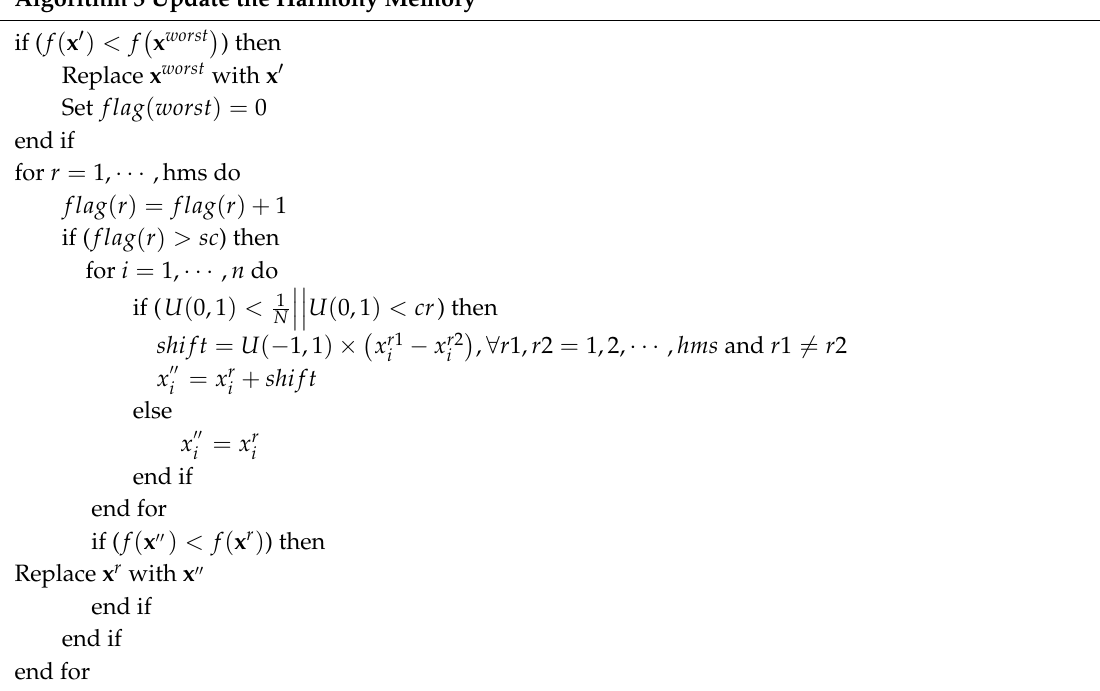
Algorithm 3 Update the Harmony